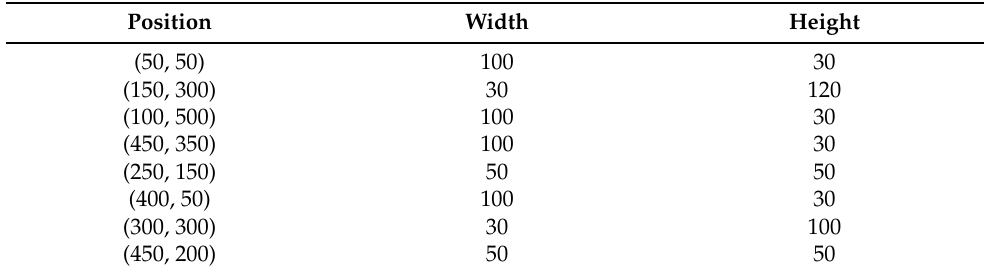
Table 2. The position of the lower left vertex, width, and height of the rectangular